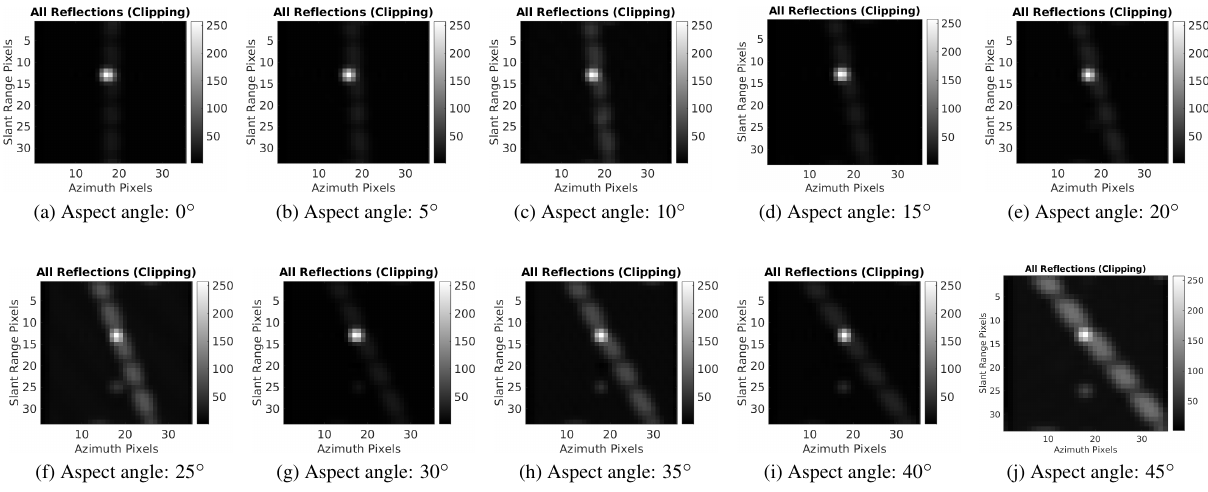
Figure 4. Simulated phase center positions for light pole in azimuth and range; blue: single reflection, green: double reflection, red: triple reflection, magenta: fourfold reflection, cyan: fivefold reflection, white: shadow. Unit on axes: meter.